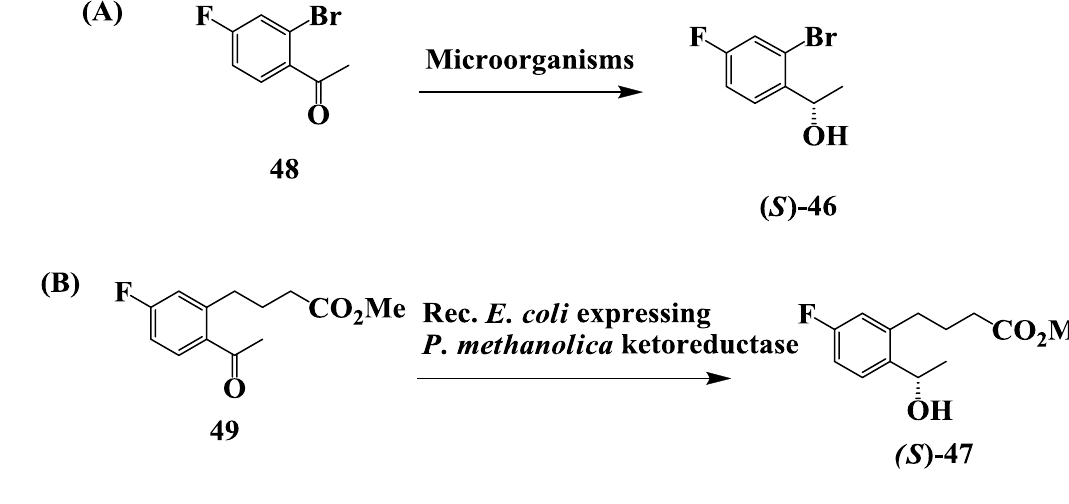
2.12. Enantioselective Microbial Reduction of Substituted Acetophenone The chiral intermediates ( S )-1-(2'-bromo-4'-fluorophenyl)ethanol 46 and ( S )-methyl 4-(2'-acetyl-5'- fluorophenyl)-butanol 47 are potential intermediates for the synthesis of several potential anti-Alzheimer’s drugs [76]. The chiral intermediate ( S )-1-(2'-bromo-4'-fluoro phenyl)ethanol 46 (Figure 12A) was prepared by the enantioselective microbial reduction of 2-bromo-4-fluoro acetophenone 48 [77]. Organisms from genus Candida , Hansenula , Pichia , Rhodotorula , Saccharomyces , Sphingomonas and Baker’s yeast reduced 48 to 46 in >90% yield and 99% enantiomeric excess (e.e.). Figure 12. ( A ) Anti-Alzheimer’s drugs: Enantioselective microbial reduction of substituted acetophenone; ( B ) Enantioselective microbial reduction of methyl-4-(2'-acetyl- 5'-fluorophenyl)